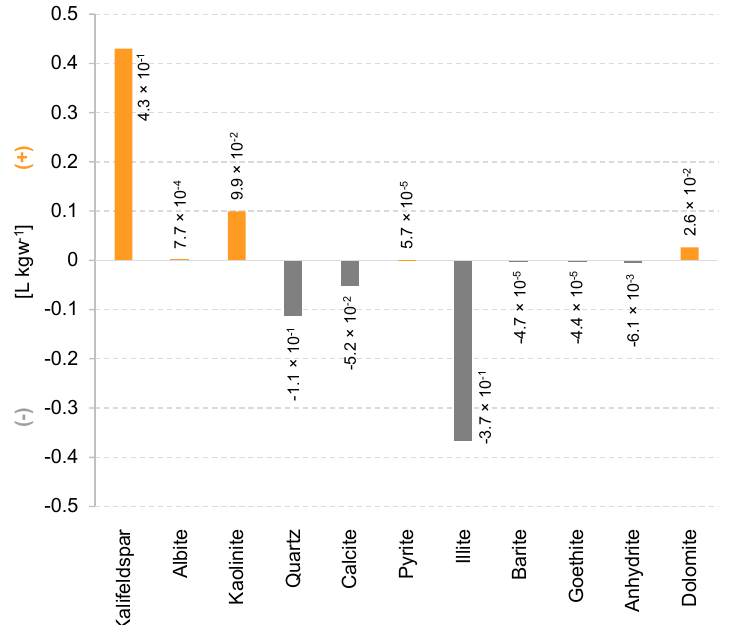
Figure 3. Volume changes of mineral phases (L kgw − 1 ) in the reservoir rock after 30 years of hydrogen storage (reference scenario).